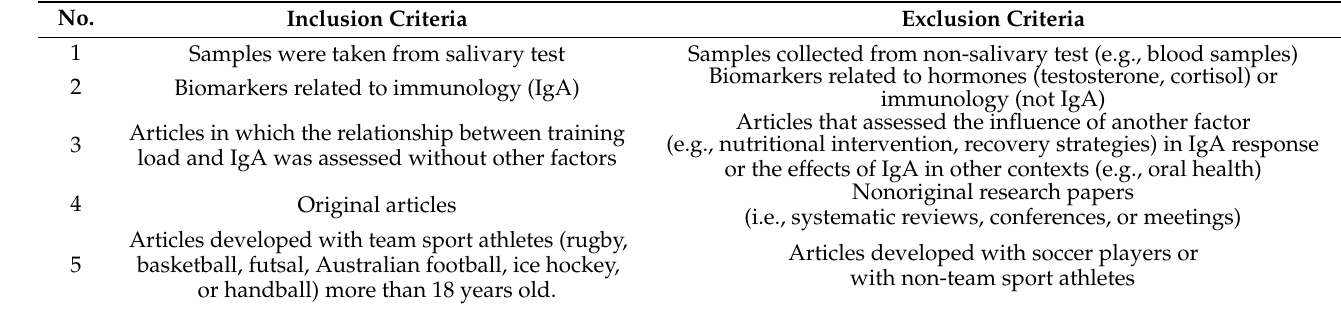
Table 1. Inclusion/exclusion criteria.